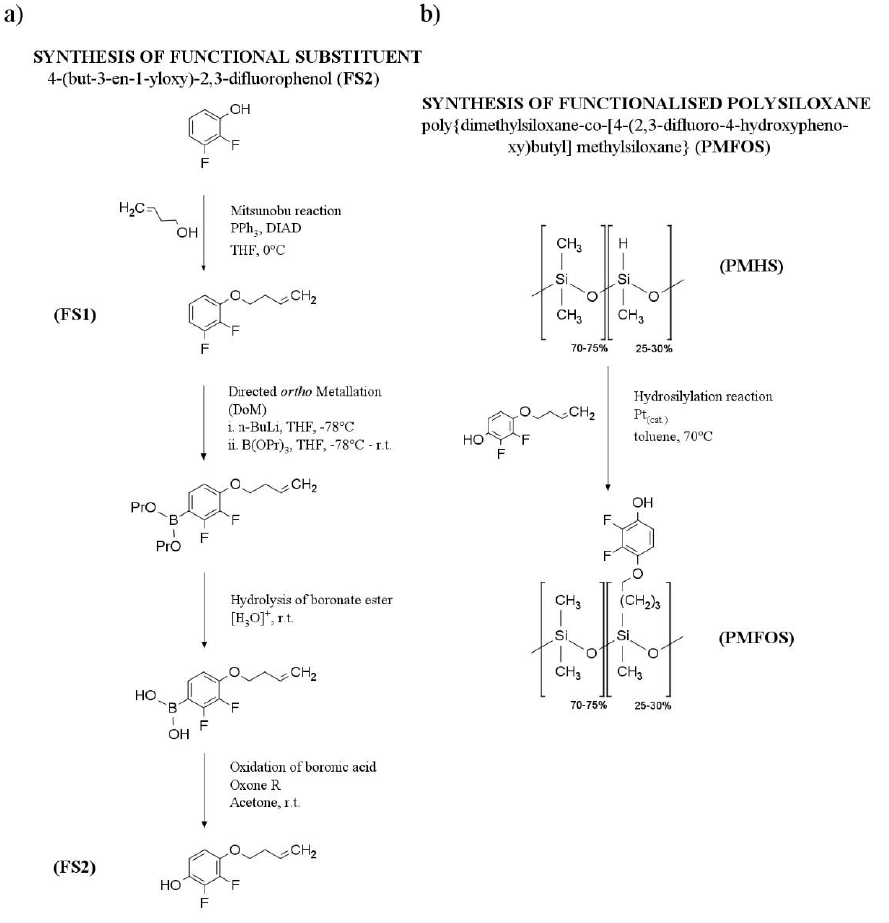
Figure 3. Synthetic protocol of PMFOS.